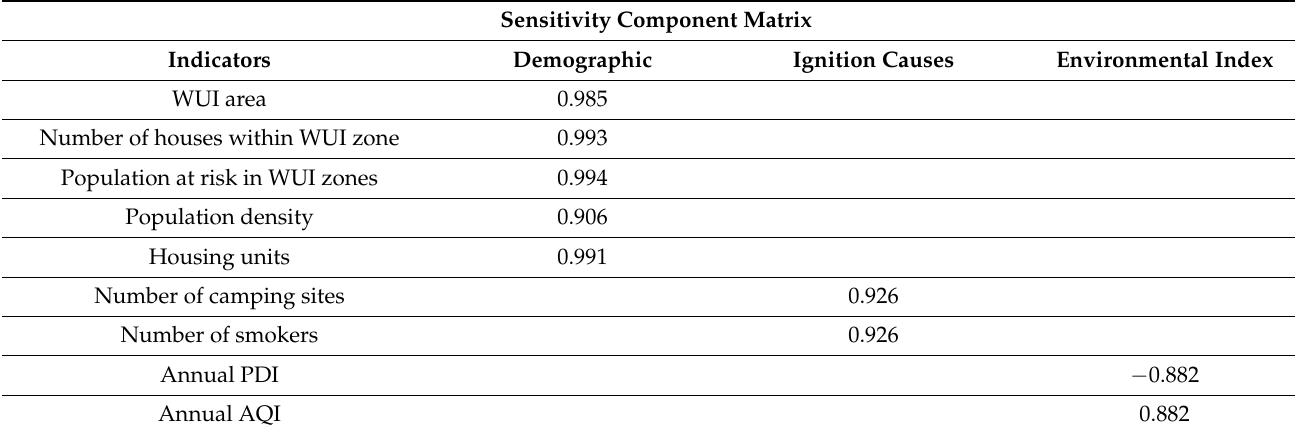
Table A7. A matrix loading table, showing each indicator variable for the sensitivity contributing factor and its respective loading into each major component (demographic, ignition causes, and environmental